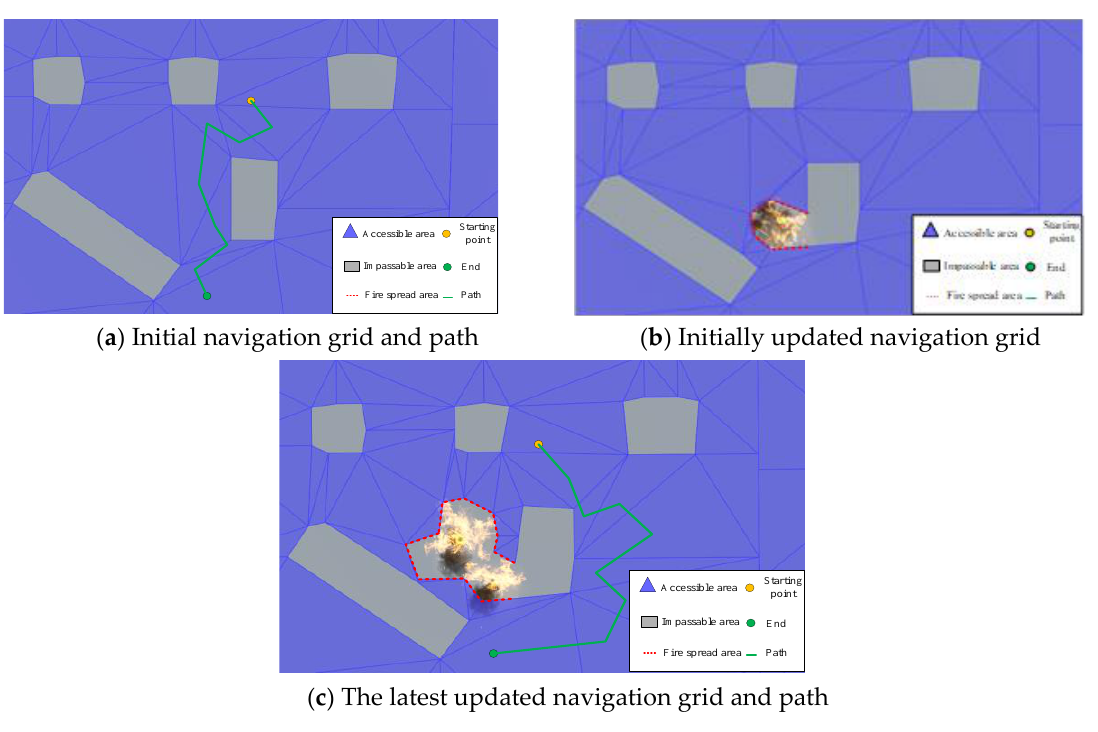
Figure 16. Path planning based on dynamic update of navigation grid.